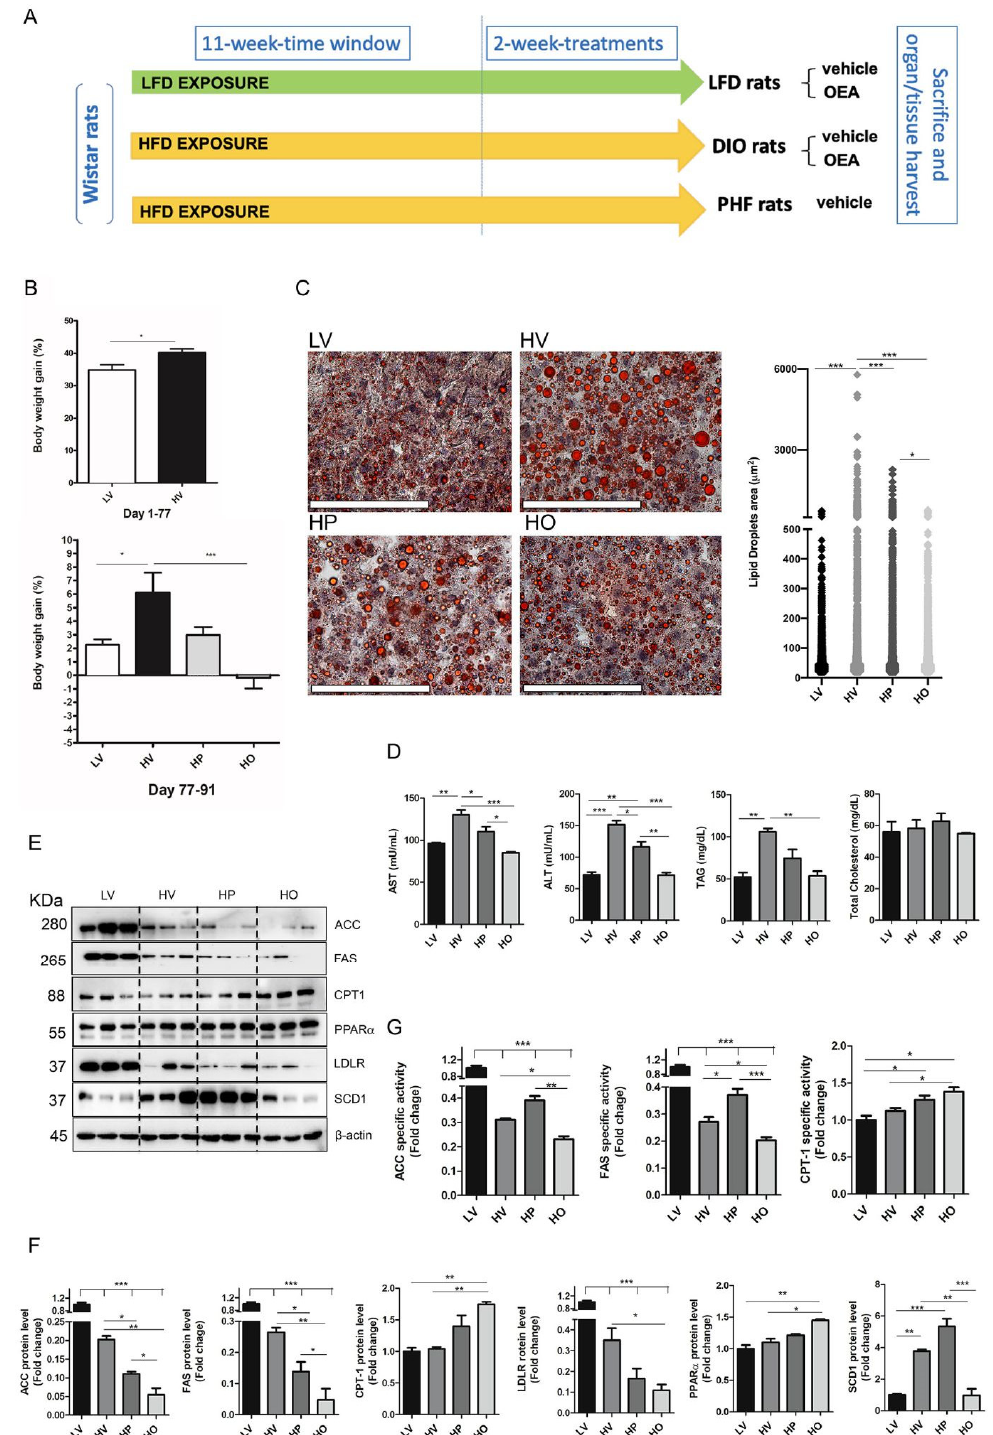
Figure 1. OEA ameliorates parameters of liver steatosis. ( A ) Schematic representation of rat treat- ments ( n = 20). ( B ) Body weight gain was measured after the pre-experimental period (77 days) and at the end of the experimental period (77–91 days). ( C ) Representative microscopic observations of the Oil red-O-stained lipid droplets and relative quantification from low-fat (LV) ( n = 5), high fat (HV) ( n = 5), pair feeding (HP) ( n = 5) and HV+OEA (HO) ( n = 5) rats. Scale bar = 50 μ m. ( D ) Plasma levels of aspartate aminotransferase (AST), alanine aminotransferase (ALT), triacylglycerols (TAG) and total cholesterol in the four experimental groups. Values in the histogram represent the mean ± SEM ( n = 4). ( E ) Representative immunoblots for acetyl-CoA carboxylase (ACC), fatty acid synthase (FAS), carnitine palmitoyltransferase-1 (CPT-1), peroxisome proliferator-activated receptor α